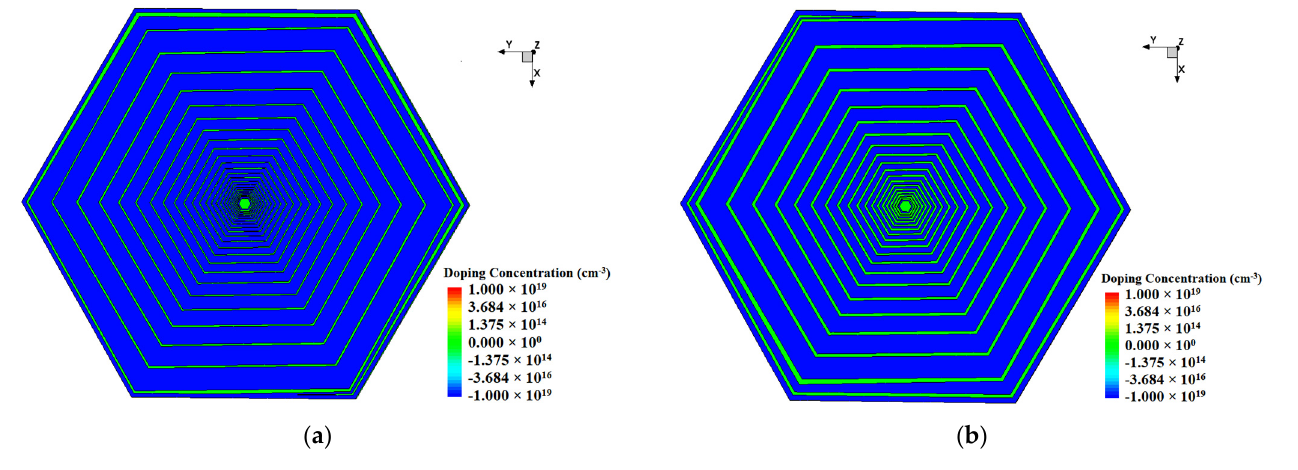
Figure 4. Backside view of the SDD: ( a ) gap 10 µm; ( b ) gap 25 µm.